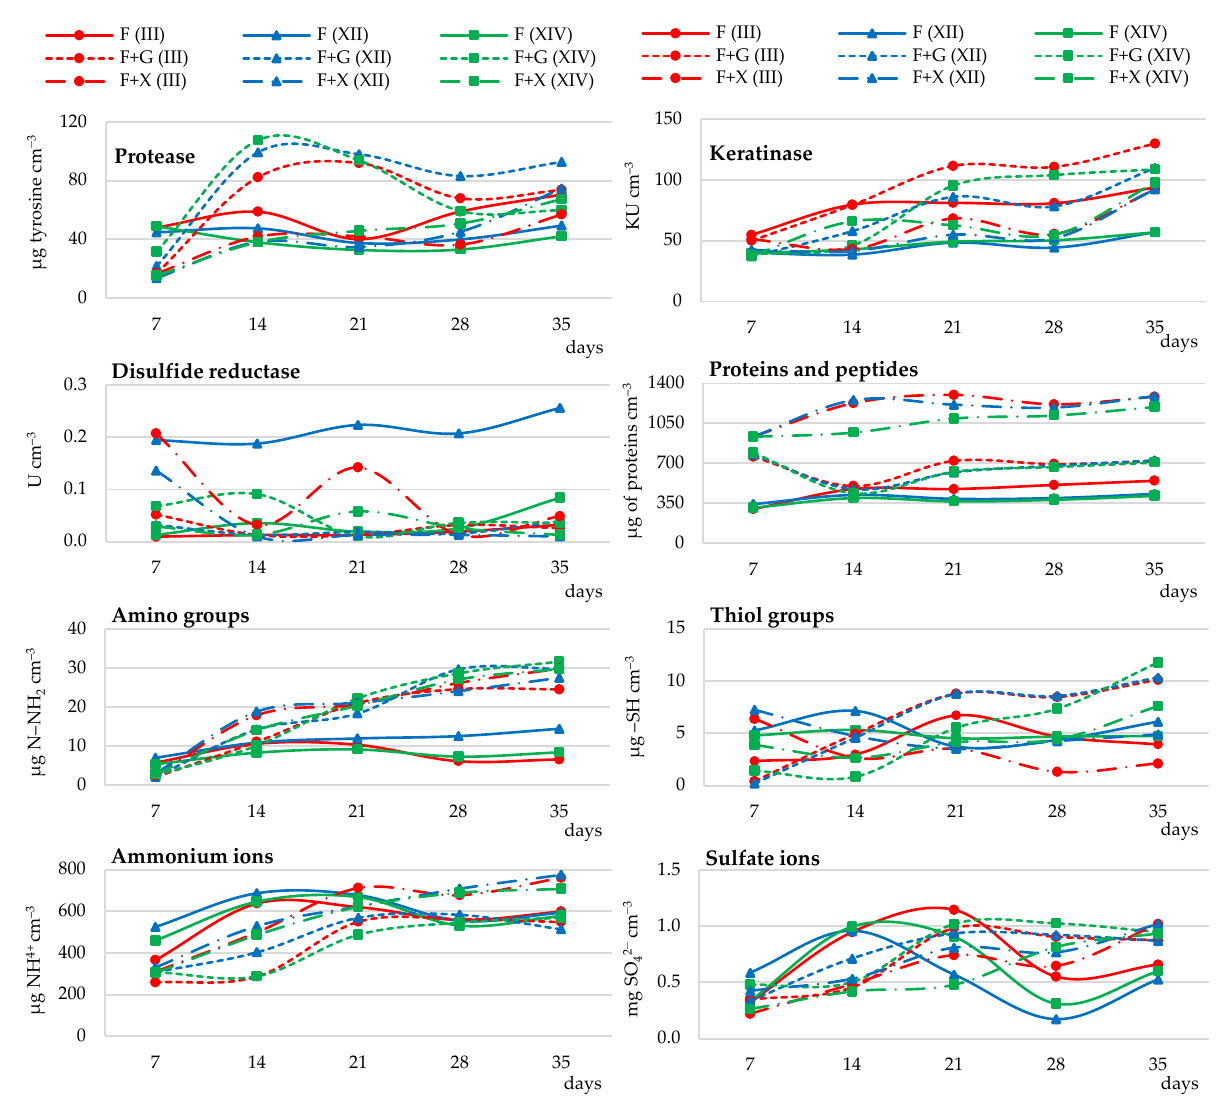
Figure 1. Dynamics of changes in enzymatic activity and released organic and mineral products of keratinolysis in cultures of three Trichophyton ajelloi strains III, XII, and XIV, with the addition of various easily available sources of carbon and energy, i.e., glucose (G) and xylose (X). Release of Soluble Proteins, Peptides and Amino Acids